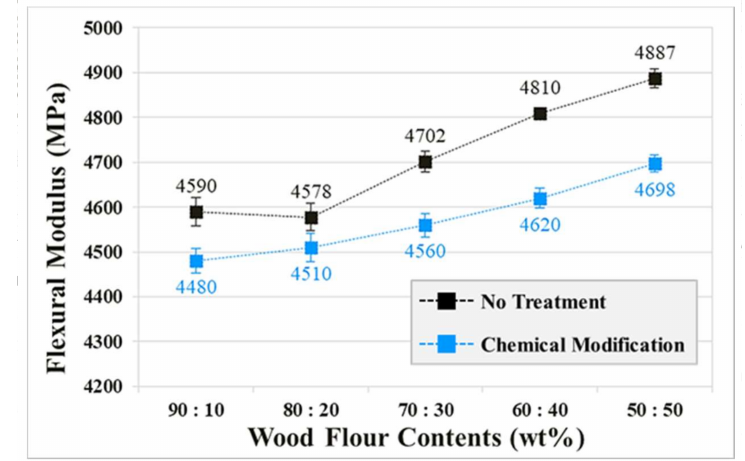
Figure 11. The flexural modulus of chemically modified and untreated wood-plastic composite injection-molded ASTM